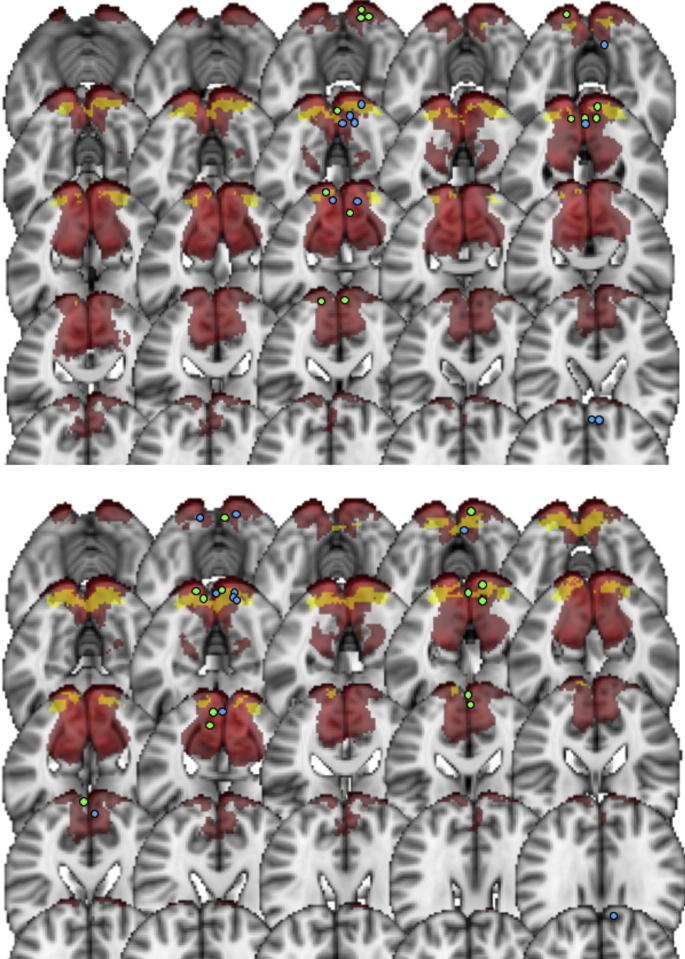
The location of the ROI used to extract the BOLD and CBF responses (yellow) for every participant, overlaid on the primary visual cortex (red). The top plot shows the left eye analysis and the bottom plot shows the right eye analysis. The dots indicate the location of the peak voxel (peak of the gamma response, percentage change from baseline) for each individual participant (blue = controls, green = MS patients), which was used for the time–frequency analysis of the MEG data. This is shown for n = 10 controls n = 13 MS patients.